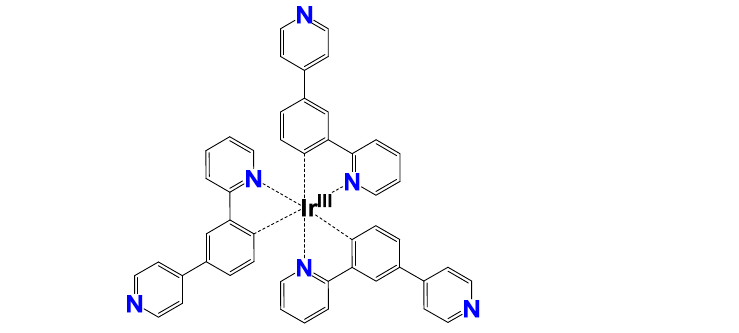
Figure2. Molecularstructureof[Ir III (4Py-ppy) 3 ]( = tris[2-(2-pyridinyl- κ N )-4-(4-pyridinyl)phenyl- κ C ]iridium)( 1 Figure 2. Molecular structure of [Ir III (4Py-ppy) 3 ] (= tris[2-(2-pyridinyl- κ N )-4-(4-pyridinyl)phenyl- κ C ]iridium) ( 1 ).